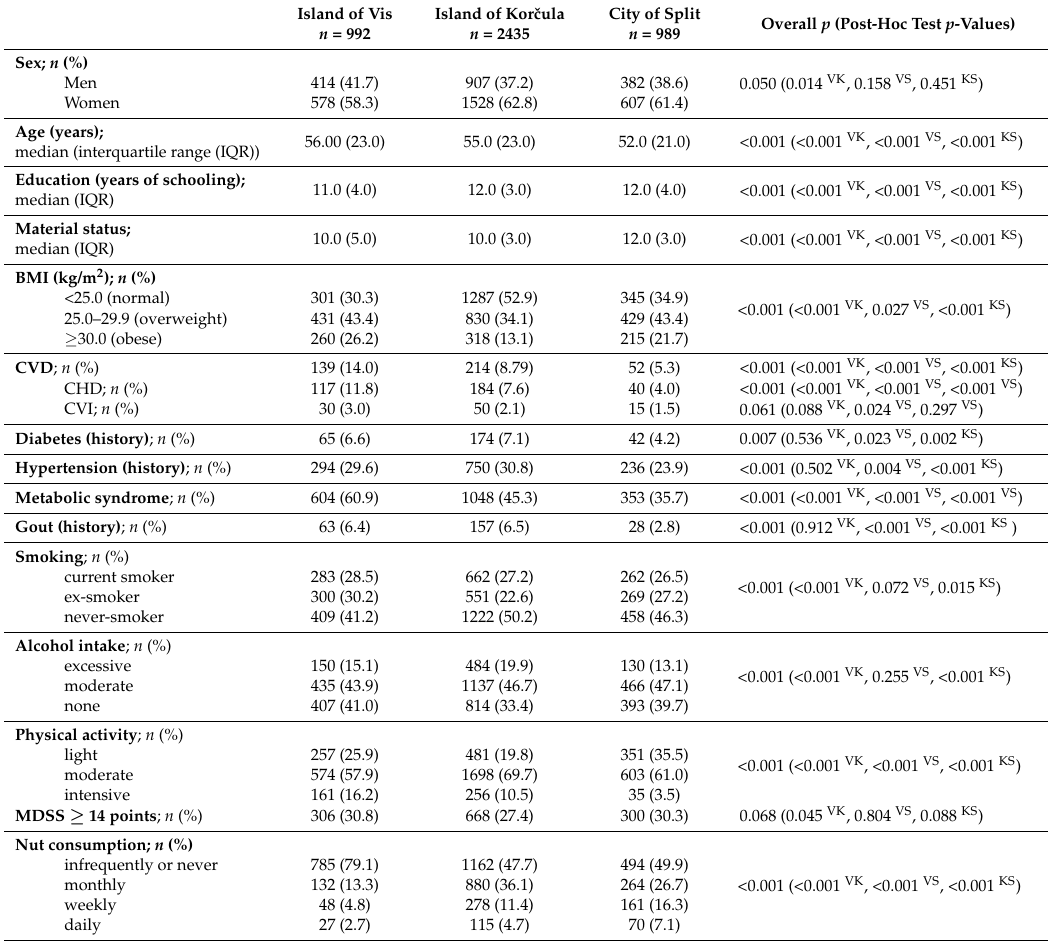
Table 1. Demographic characteristics, prevalence of chronic diseases, lifestyle characteristics, Mediterranean diet compliance (MDSS ≥ 14) and nut consumption frequency according to the place of residence. Island of Vis Island of Korˇcula City of Split n = 992 n = 2435 n = 989 Overall p (Post-Hoc Test p